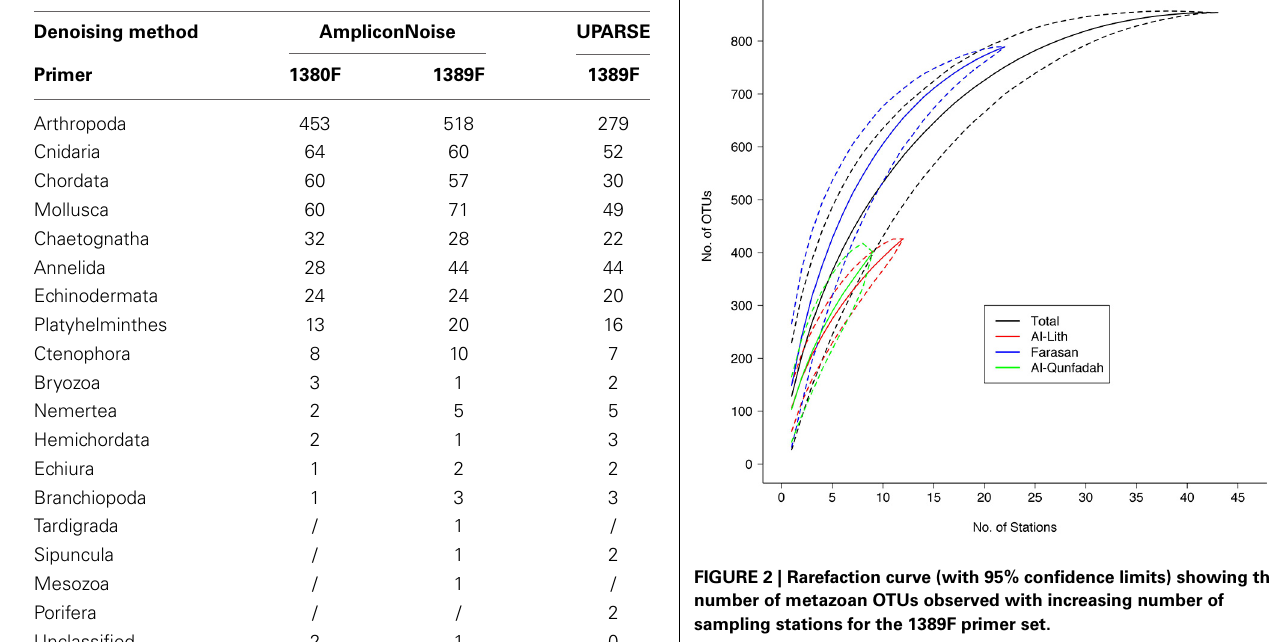
Table 3 | Number of 97% OTUs attributed to each metazoan phyla.